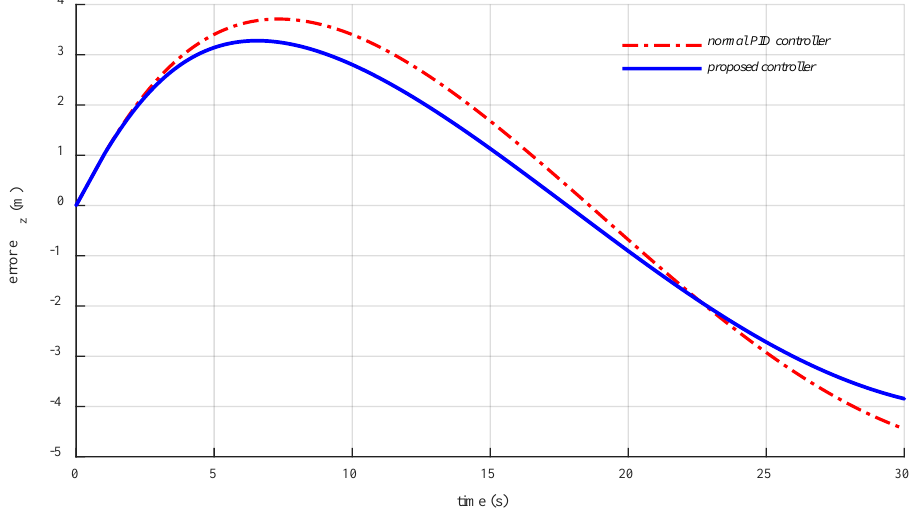
Figure 13. Comparison of the altitude tracking error convergence between our new controller and a conventional PID controller in Scenario 2.